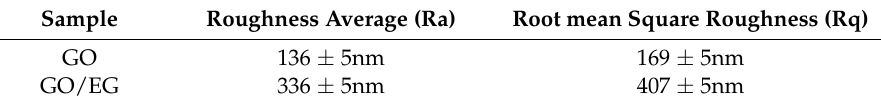
Table 2. Roughness parameter of the surface of GO and GO/EG membrane.